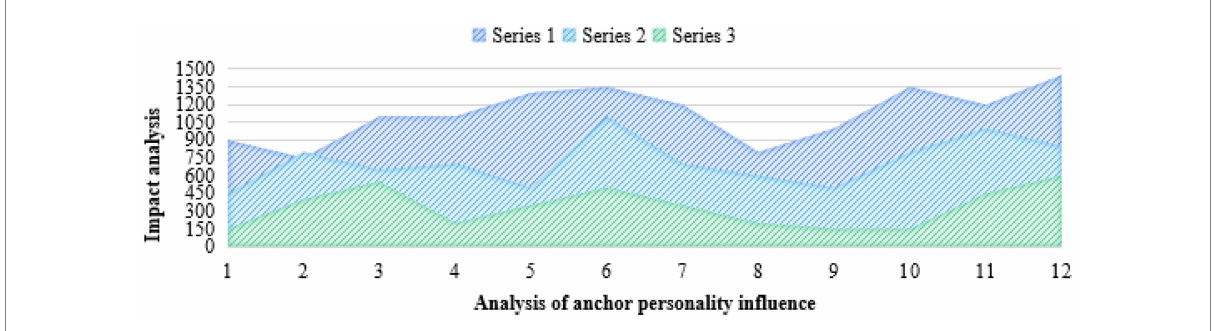
FIGURE 7 Analysis of the influence of anchor personality.